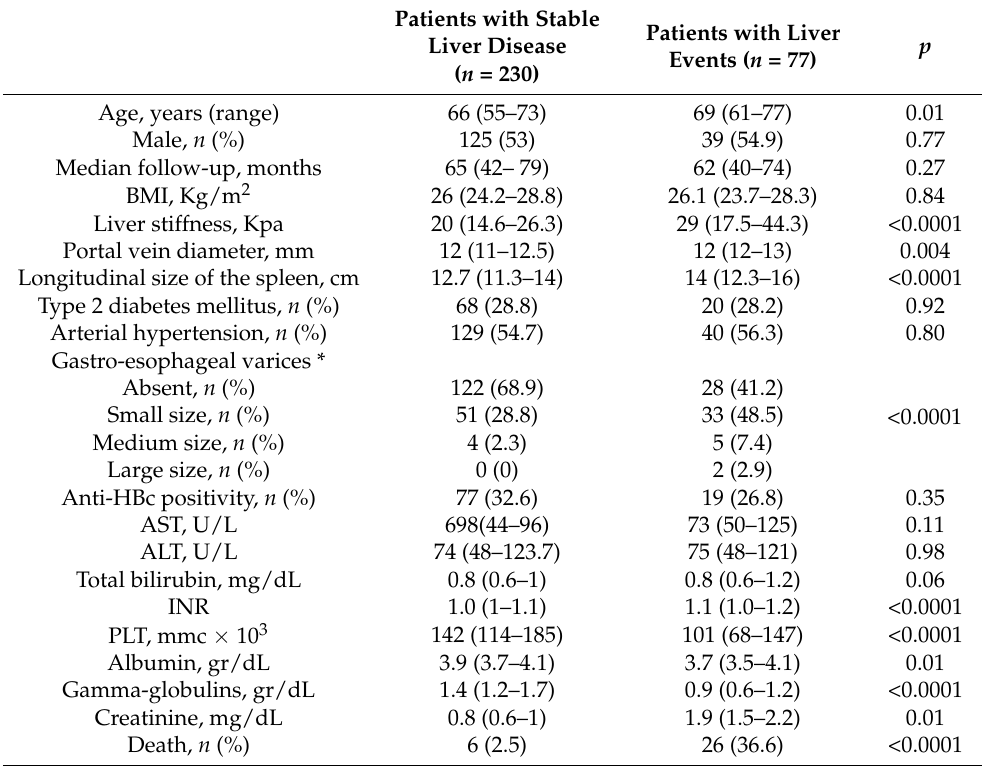
Table 2. Baseline demographic, clinical and laboratory characteristics of 307 C-P class A HCV cirrhotic patients with stable liver disease (230 cases) and patients that developed liver events (77